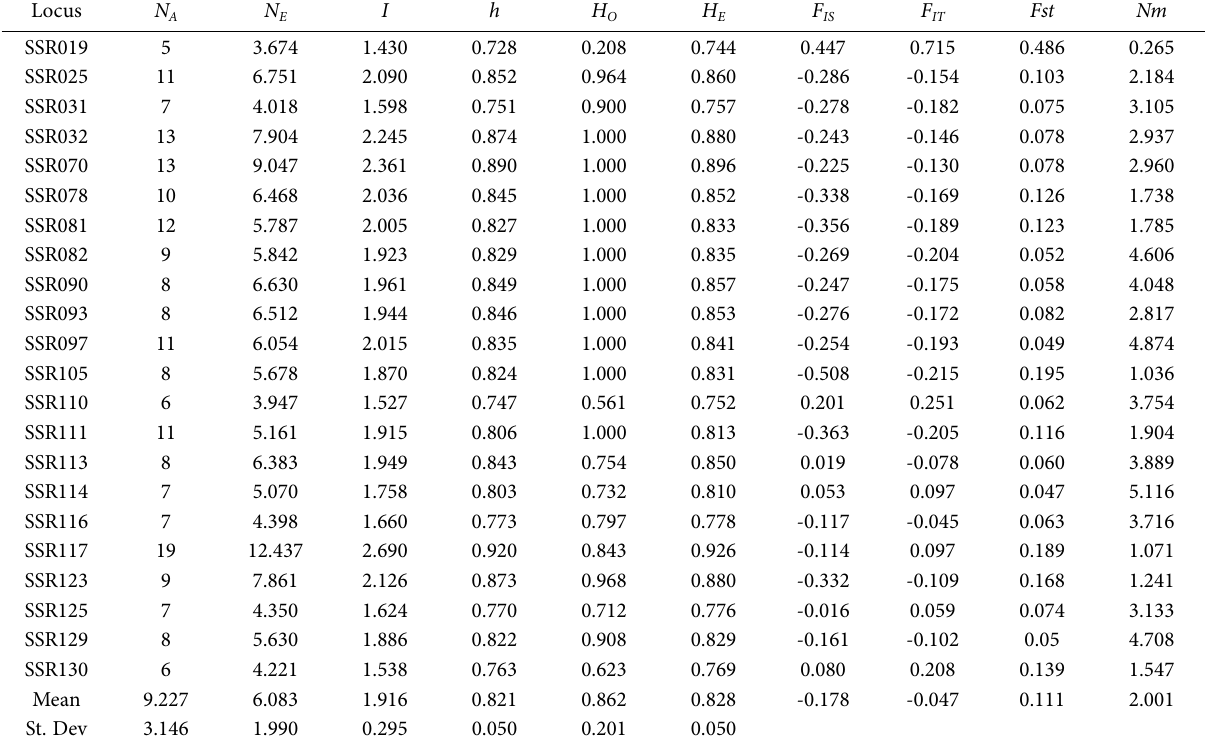
Table 3 Genetic diversity of R. simsii populations based on SSR markers, including Number of alleles ( N A ), effective number of alleles ( N E ), Shannon’s information index ( I ), Nei’s gene diversity ( h ), observed heterozygosity ( H O ), expected heterozygosity ( H E ), intra-population inbreeding coefficient ( F IS ), total-population inbreeding coefficient ( F IT ), inter-population genetic differentiation coefficient ( F ST ), and gene flow ( Nm ). Locus N A N E